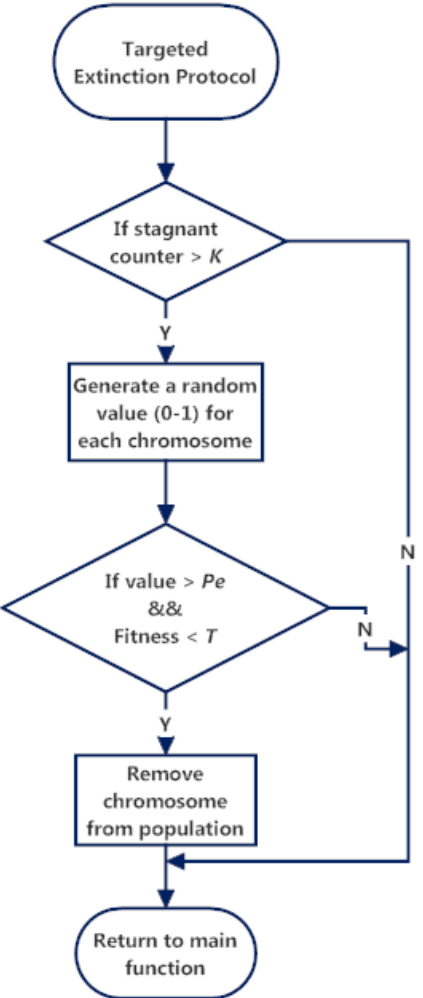
Figure 4. Flowchart of Targeted Extinction